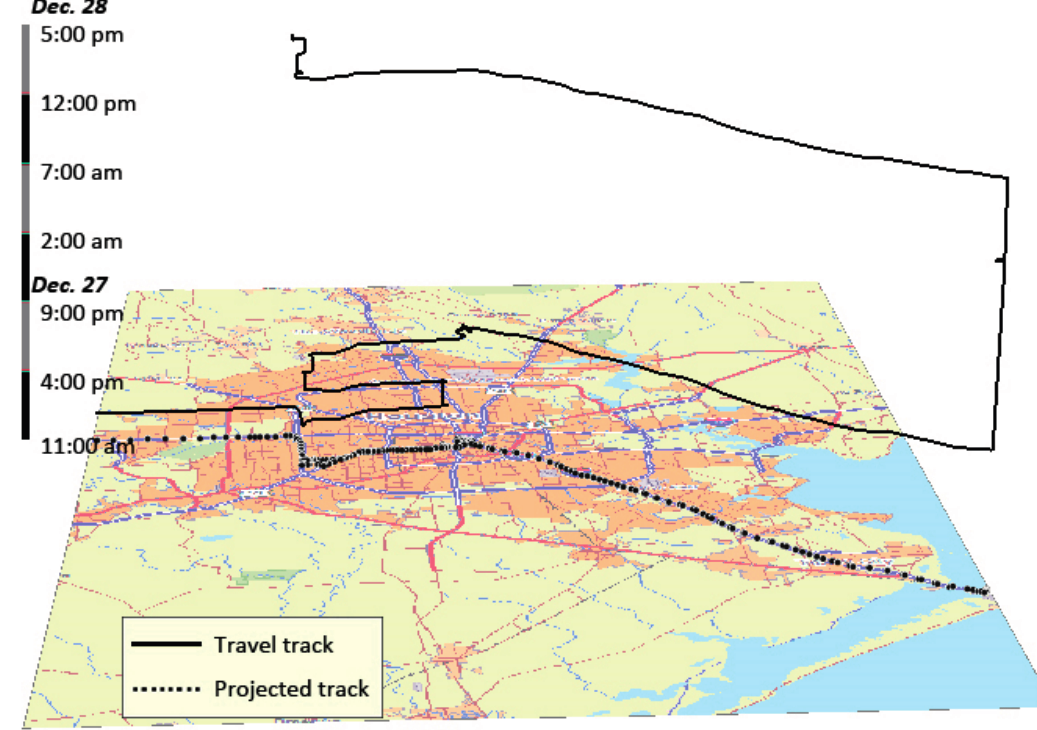
Figure 3. The space-time path of the volunteer in Houston, Texas on 27 and 28 December 2010. The recorded O 3 concentration values ranged from 20 ppb to 80 ppb on 27 and 28 December